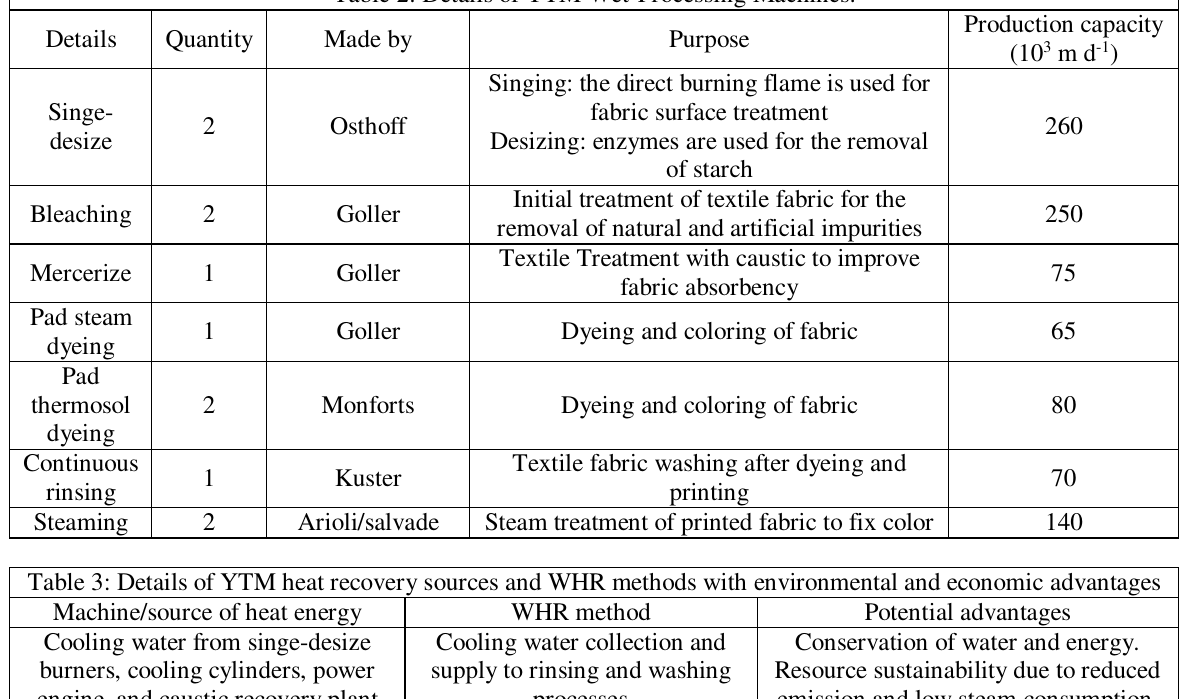
Table 3: Details of YTM heat recovery sources and WHR methods with environmental and economic advantages